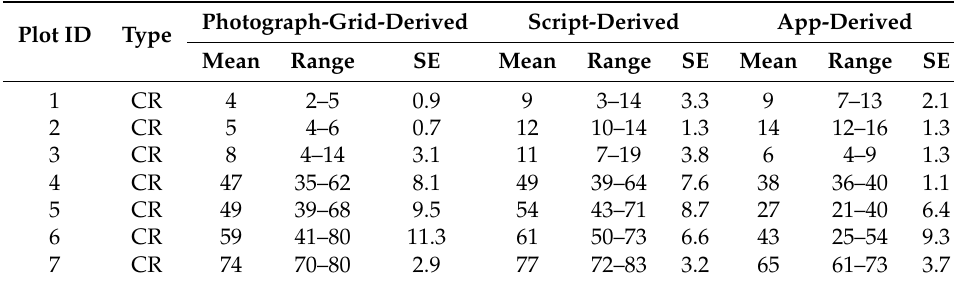
Table 1. Summary statistics for residue cover percent derived from app, photograph-grid and script methods in the studied 18